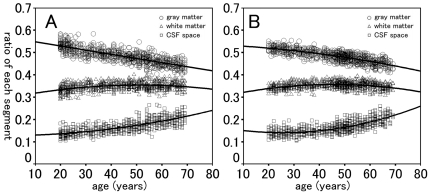
Relationship between ratios of gray matter, white matter, and CSF fluid space segments and age for men (A), and women (B).Circles represent gray matter ratio, triangles represent white matter ratio, and squares represent CSF space ratio.